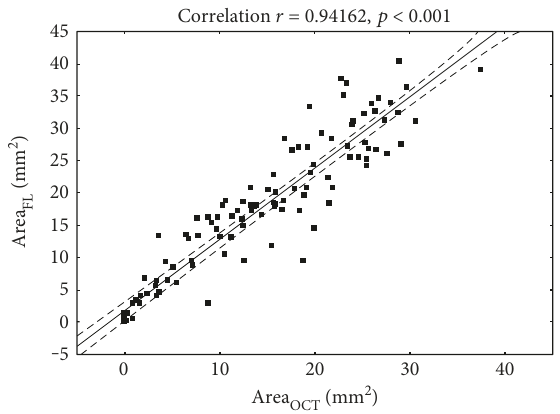
Figure 2: Correlation between areas of defect as measured by photography after fl uorescein staining or optical coherence